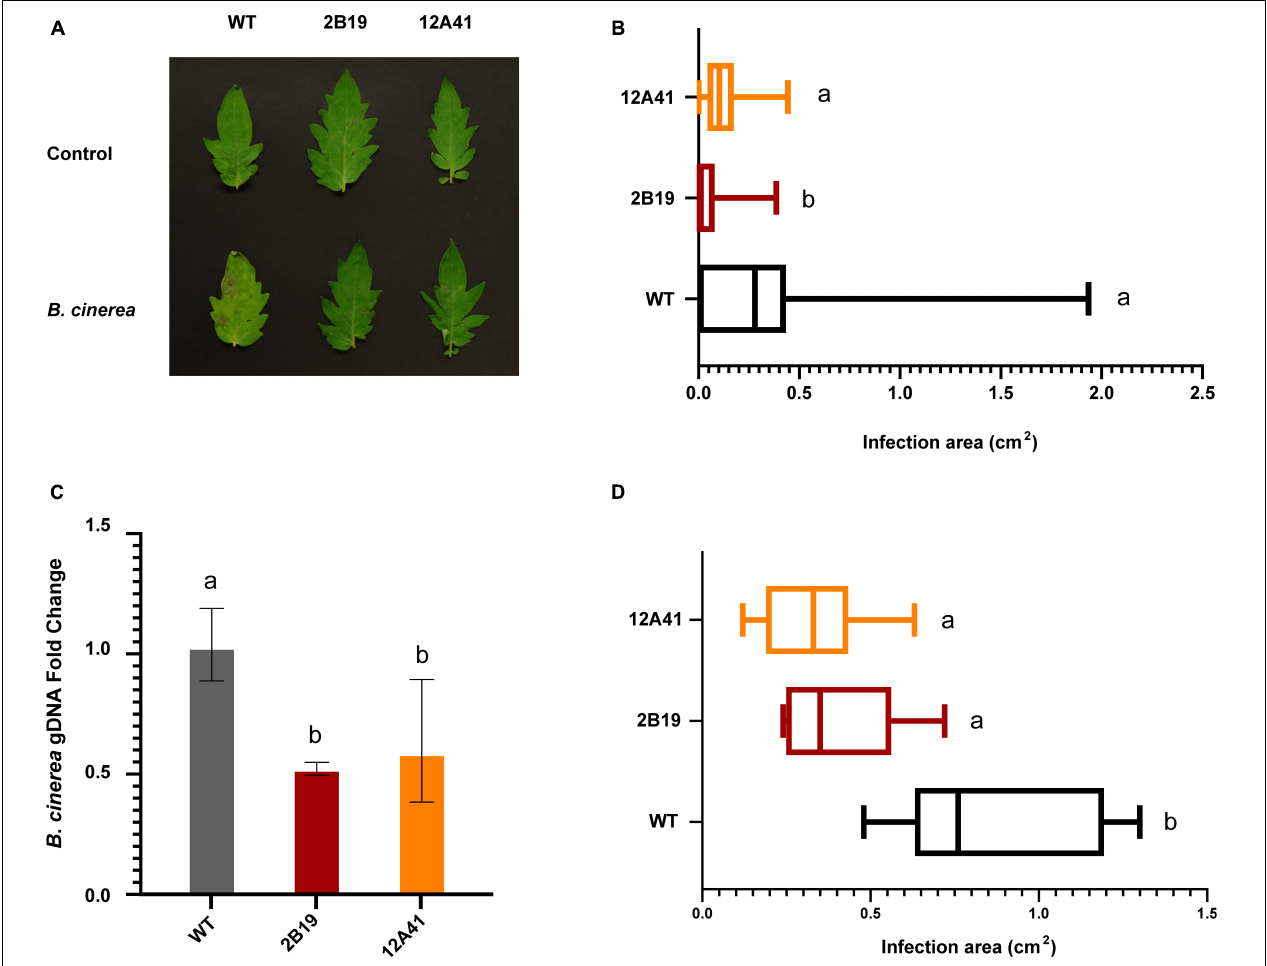
FIGURE 5 | Association between gf mutations and pathogen resistance in tomato. (A) Infected and control tomato leaves 7 dpi. WT and gf tomato leaves infected with B. cinerea conidia or mock-infected with water (control). (B) Infection area of WT and gf tomato leaves infected with B. cinerea , 7 dpi. Bars indicate medians and extremes. Variables within the same statistical groups are marked with the same letters (Kruskal-Wallis ANOVA and Dunn’s post-hoc test, p < 0.05). (C) qPCR relative quantification of fungal gDNA from infected leaves. Values represent the fold change variation of B. cinerea genomic DNA in infected mutant gf leaves, relative to WT samples. Bars represent SD. Variables within the same statistical groups are marked with the same letters (ANOVA and Games-Howell post-hoc test, p < 0.001). (D) Infection area in full-ripe tomato fruits inoculated with B. cinerea , 7 dpi. Bars indicate medians and extremes. Variables within the same statistical groups are marked with the same letters (ANOVA and Games-Howell post-hoc test, p <